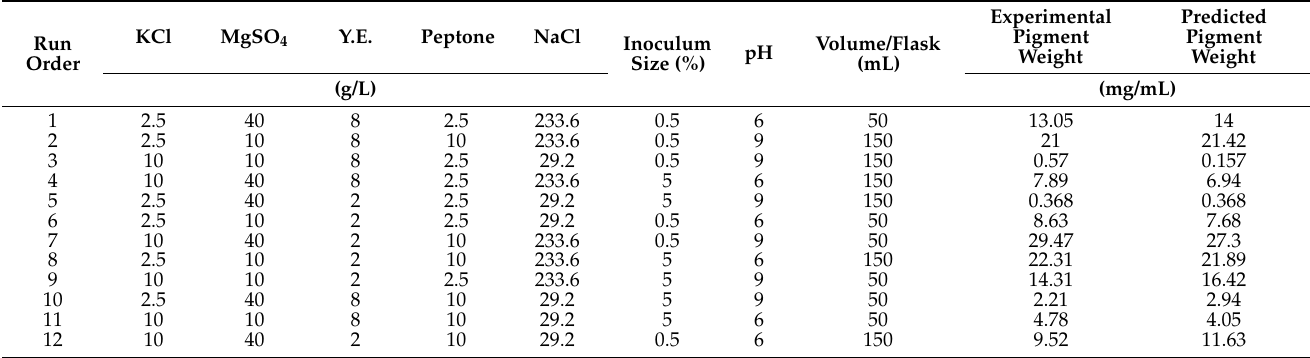
Table 1. Twelve-experiment Plackett–Burman matrix for evaluation of independent factors with high/ low values along with the actual and predicted response (pigment